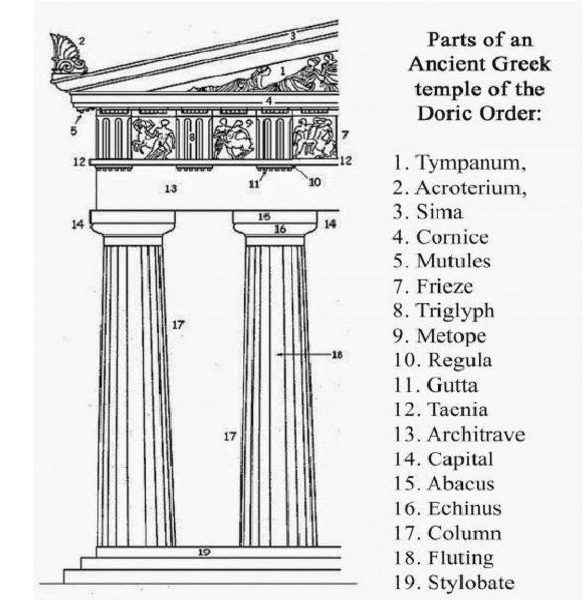
Figure 2 . The parts of an Ancient Greek temple of the Doric order. (source: https://gr.pinterest.com/pin/